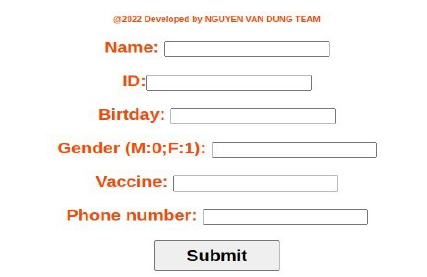
Figure 12. Display of the manual options page.